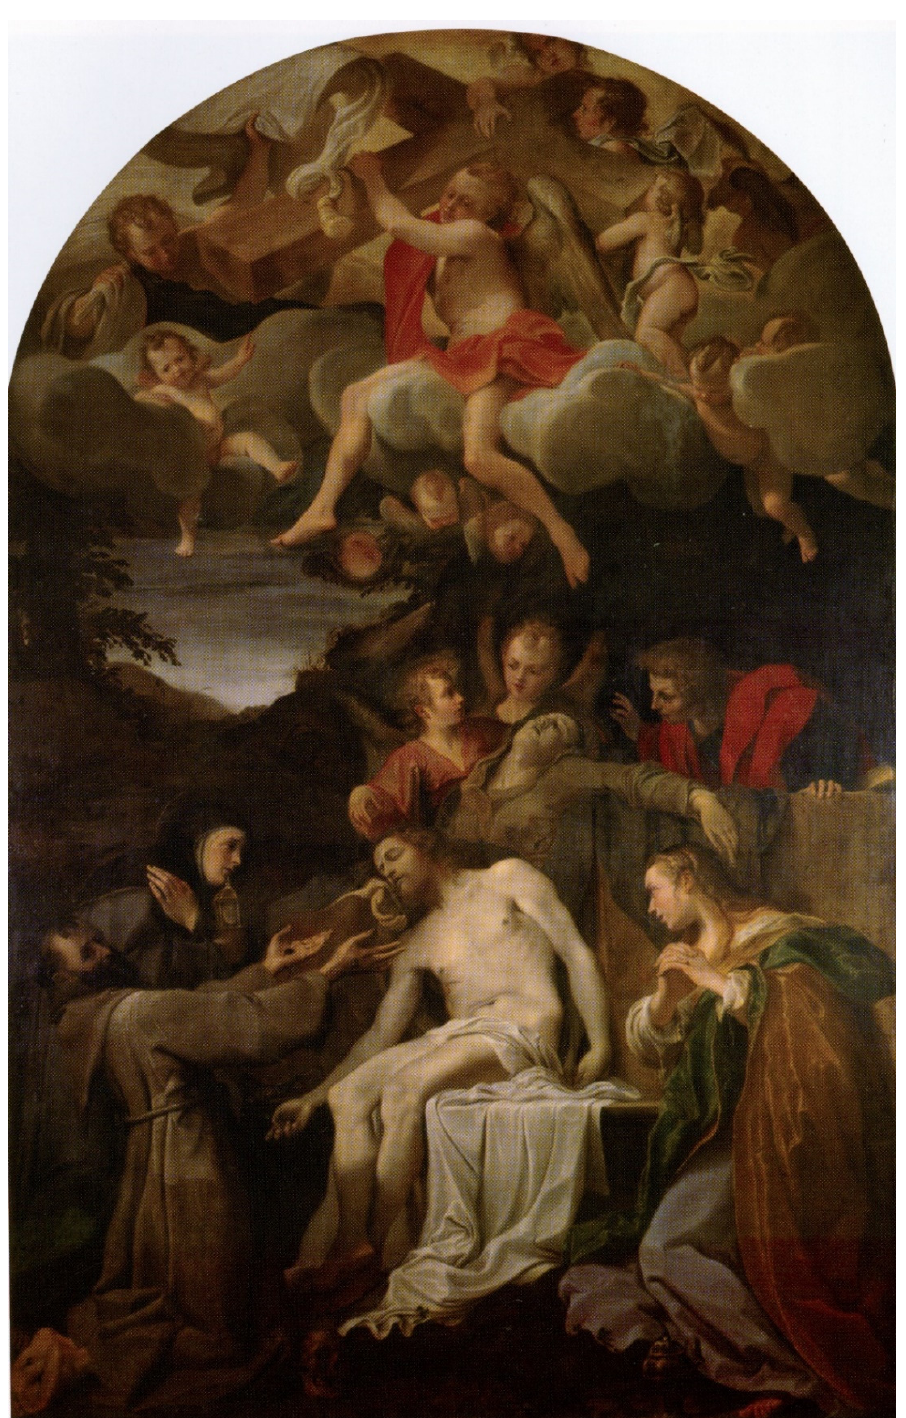
Figure 1. Annibale Carracci, Pietà with Saints , 1585. Panel. Galleria Nazionale, Parma, Italy. Image Courtesy of Galleria Nazionale, Parma, Italy; https://useum.org/museum/Galleria-nazionale-di- Parma (accessed on 20 June 2021).